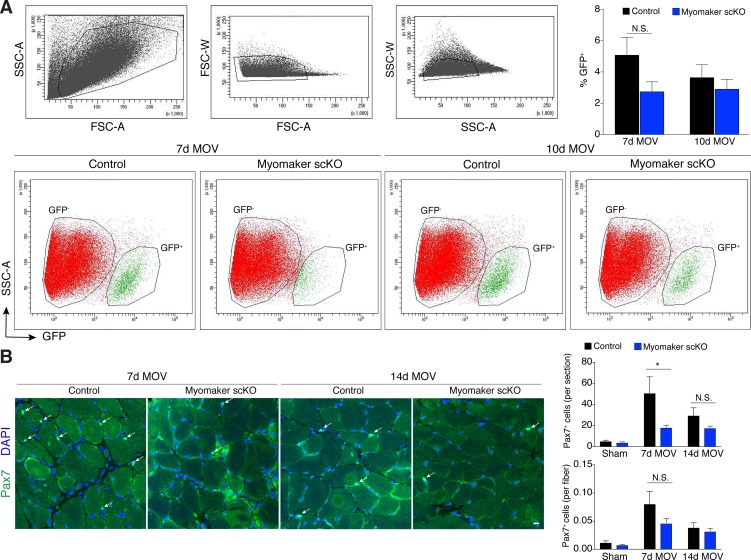
Myogenic progenitors are maintained in myomaker scKO muscle during MOV.(A) Flow cytometry for mGFP+ progenitors in tamoxifen-treated Pax7CreERT2/+; RosamTmG (control) and Tmem8cLacZ/loxP; Pax7CreERT2/+; RosamTmG mice (myomaker scKO) reveals a distinct GFP- (red) and GFP+ (green) population of cells 7 and 10 days after MOV. Top panels reveal gating strategy derived from forward and side scatter plots. Plots shown are representative from one experiment. Quantitative analysis confirms similar levels of mGFP+ cells between control and myomaker scKO muscles at 7 and 10d of MOV (n = 3 for each group), indicating that myogenic progenitors are present after satellite cell ablation of myomaker. (B) Representative images of Pax7+ nuclei in plantaris sections further reveal that satellite cells are present in fusion-incompetent muscles throughout two weeks of MOV. Quantification revealed a significant difference 7 days after MOV when Pax7+ cells are analyzed per section but not when normalized to fiber number (n = 4–6). Data are represented as mean ± SEM, *p<0.05. Scale bar: 10 μm.